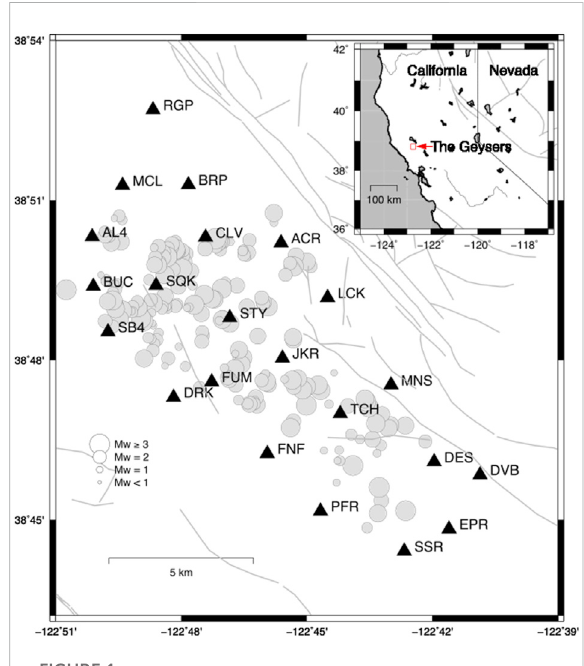
FIGURE 1 Geographic map of The Geysers geothermal fi eld, California. Black triangles identify the seismic stations. Gray circles indicate the epicentral location of the earthquakes analyzed in the present study. Circle dimension is proportional to the event magnitude. Gray lines correspond to the known quaternary faults. The red square and the red arrow in the inset indicate the location of The Geysers geothermal fi